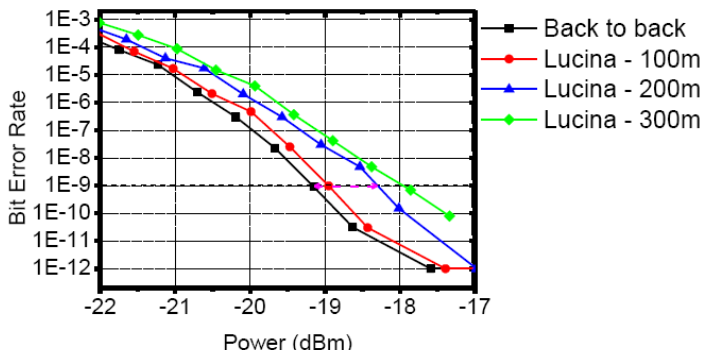
Figure 13. BER measurement as a function of the received optical